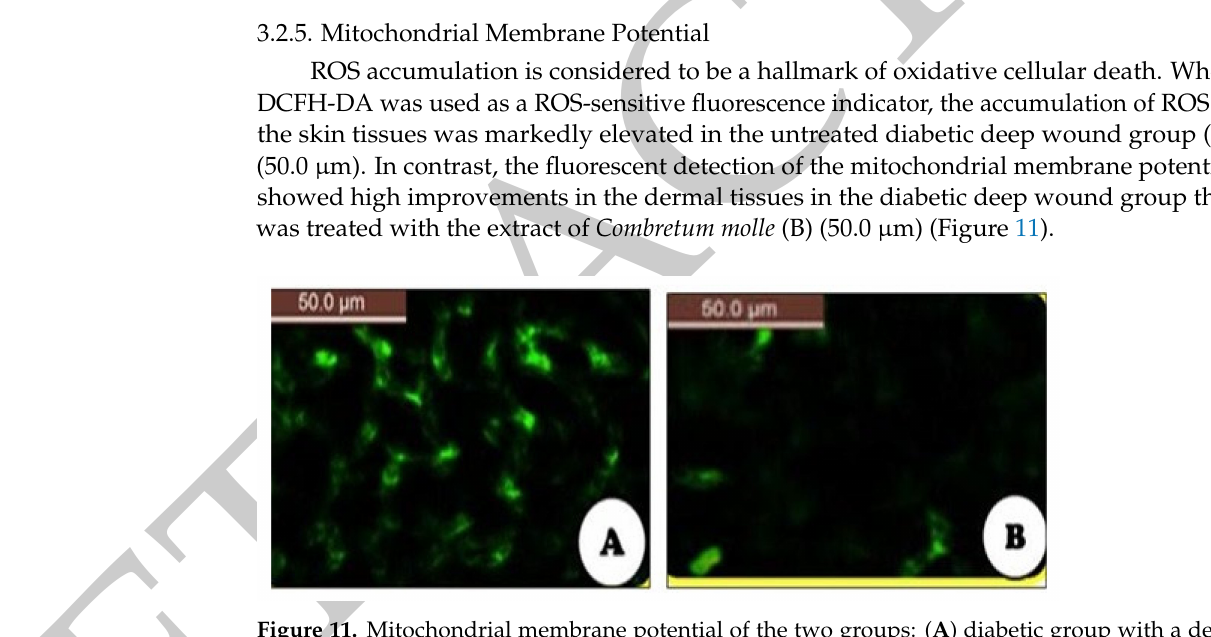
Figure 10. MMP in the serum were detected in diabetic untreated and treated group with C. molle .